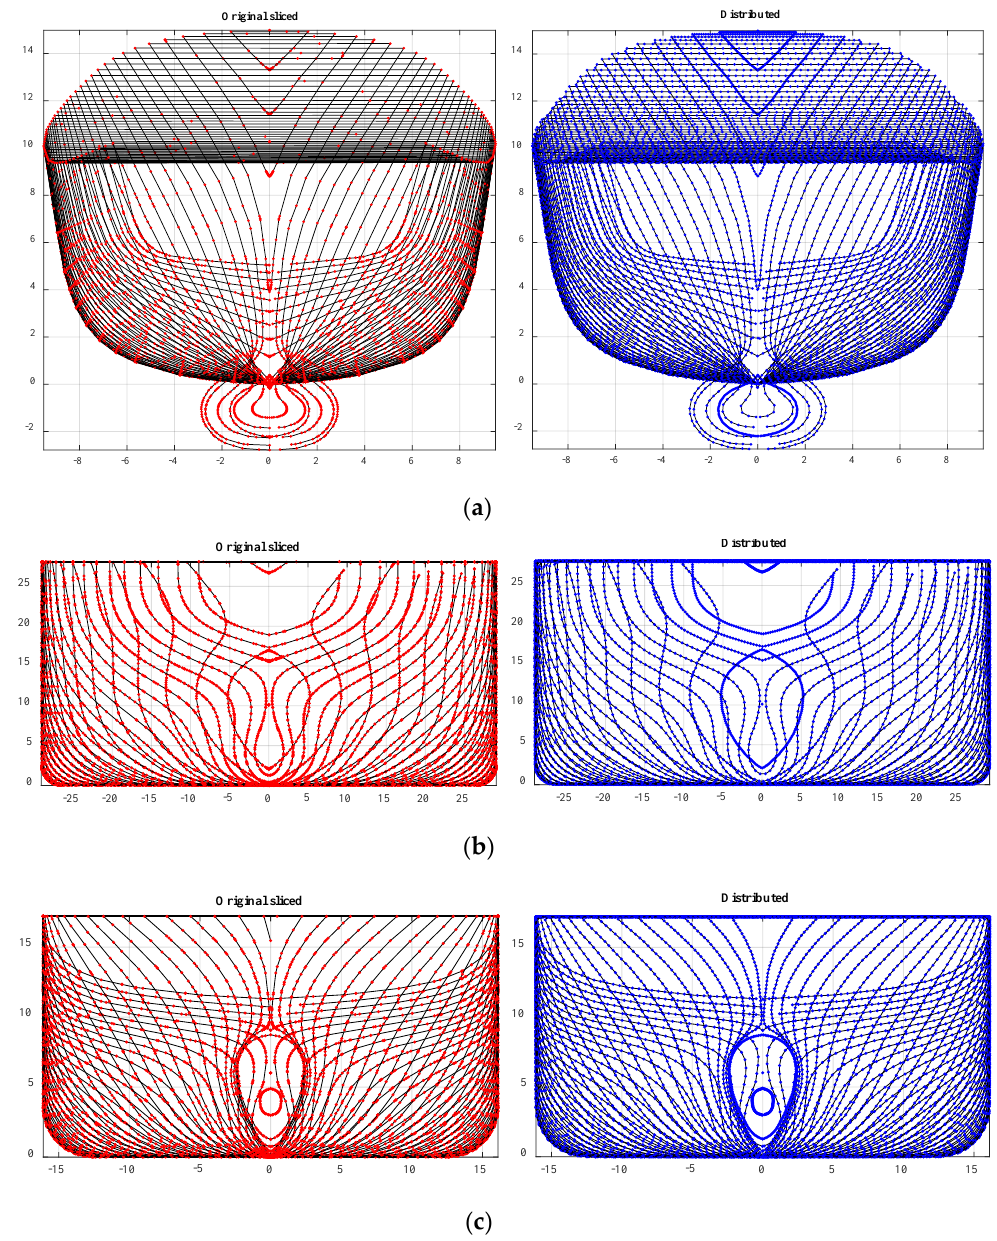
Figure 14. ( a ) Original sliced and redistributed data (DTMB 5415, 60 slices). (b) Original sliced and redistributed data (KCS, 60 slices). (c) Original sliced and redistributed data ( KVLCC2, 60 slices).